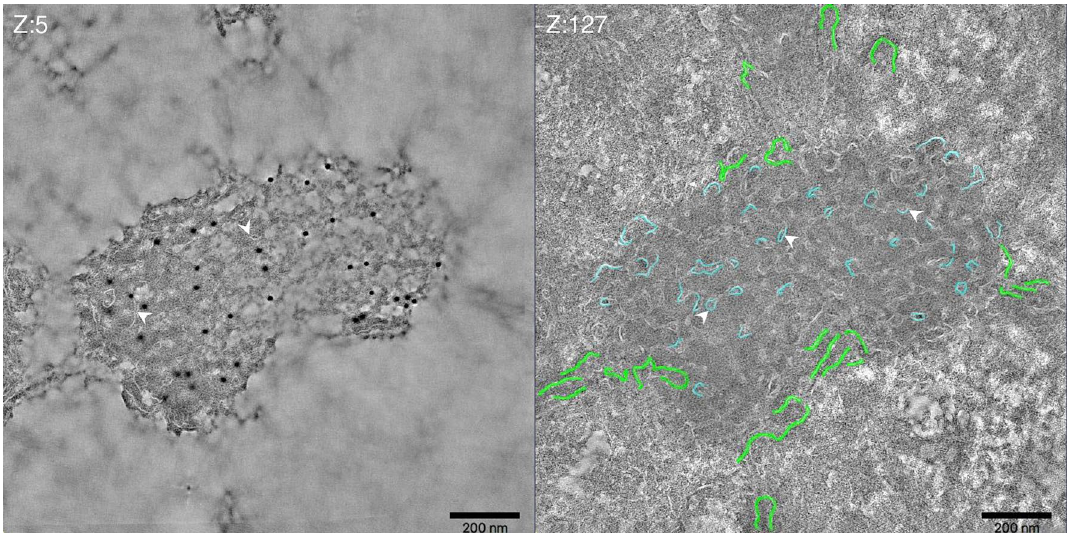
Figure 4. Short membrane tubes prominently accumulate on the D13 network. HeLa cells infected without IPTG were prepared as for Fig. 2. Sections, 150 nm in thickness, were labeled with anti-D13 and subjected to dual-axis tilt series acquisition by transmission EM. Two slices of the reconstructed tomogram; the surface of the section (Z:5) displays anti-D13 labeling and identifies the D13-positive network structure in Tokuyasu sections. The slice Z:127 illustrates that the D13 network is filled with short membrane tubes (white arrowheads) that appear as white lines due to the negative contrasting in the Tokuyasu method. A subset of the short membrane tubes is rendered in light blue, while the ER cisternae that accumulate close by are rendered in green. The slices are taken from the supplemental Movie